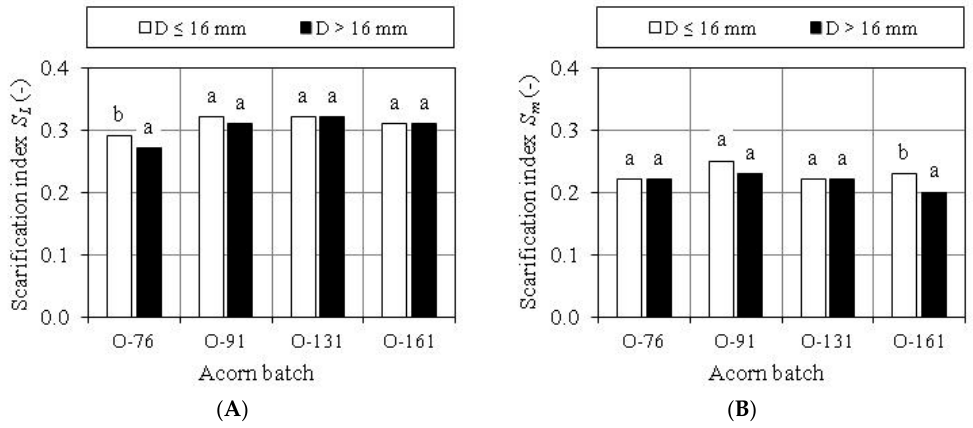
Figure 8. Significance of differences in the dimensional ( A ) and mass ( B ) scarification index of acorns measuring up to 16 mm and more than 16 mm in diameter: a, b—different letters denote statistically significant differences.